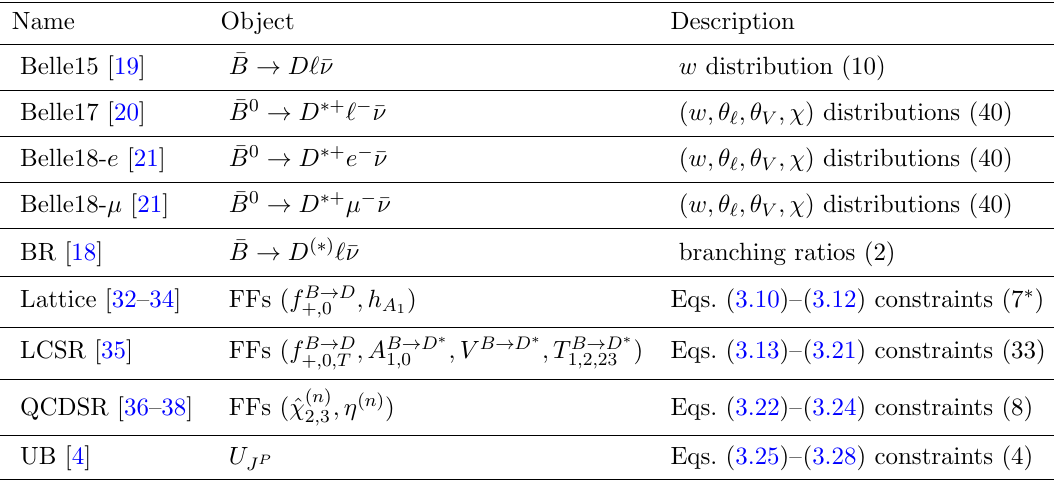
Table 1 . Summary of the experimental data and the theory constraints used in our (cid:12)t analysis. Numbers of independent data points are also exhibited in brackets. ( (cid:3) ) The relation f + ( q 2 =0) = f 0 ( q 2 =0) implies that the lattice result has only 6 independent